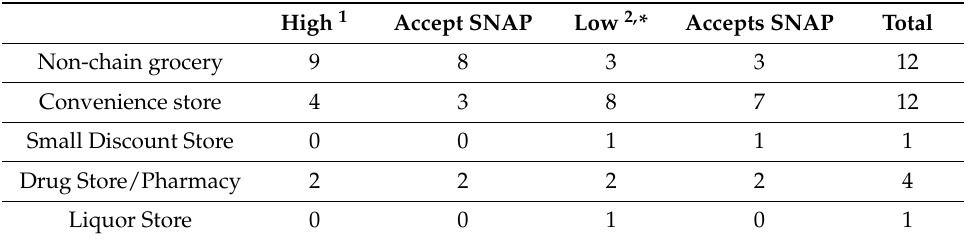
Table 2. Number of stores by store type in high and low Supplemental Nutrition Assistance Program (SNAP)/high and low racial minority tracts ( n = 30).